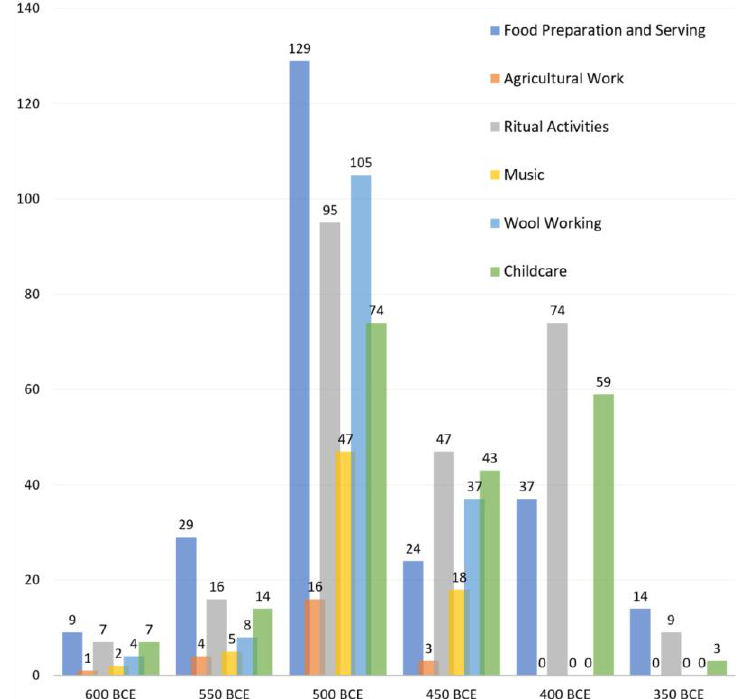
Figure 12. Chart illustrating relative numbers of select scene types featuring women, including all known provenances. Data from the BAPD. Chart created by author.